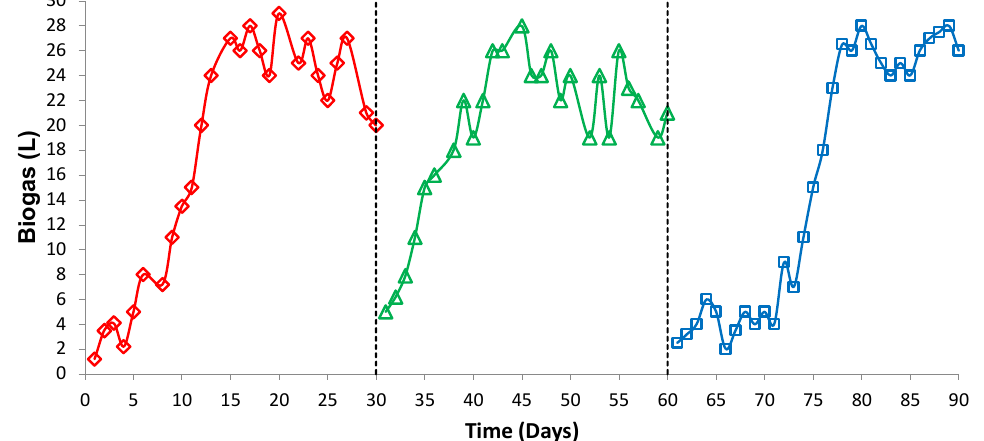
Figure 5. Biogas production in the digestion stage in batch mode.